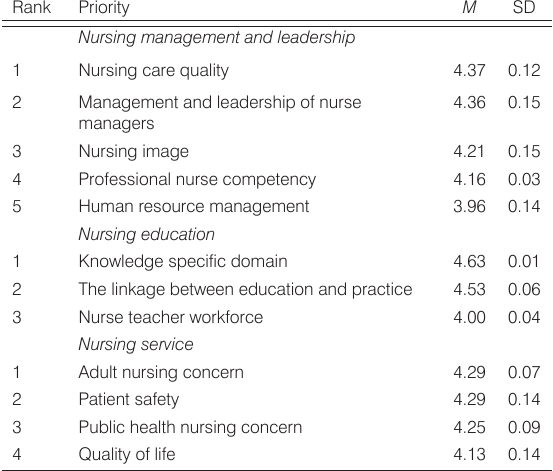
Table 3. Top priorities in the category of nursing management and leadership, nursing education, and nursing